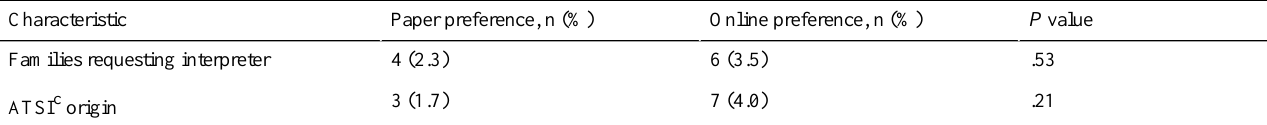
Table 4. Questionnaire modality preference for caregivers requesting an interpreter and ATSI caregivers in the EDC a group. b